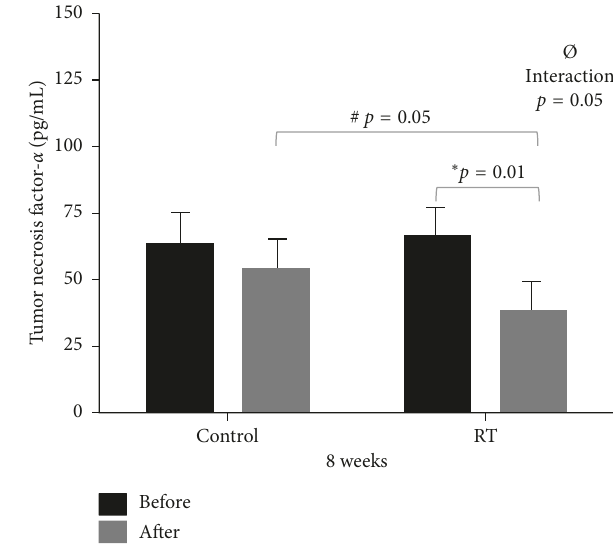
Figure 3: Dispersion measurements of tumor necrosis factor- α between Control ( n � 10) and RT ( n � 19) groups at Pre and Post moments. Two-way ANOVA test: ∗ statistically significant differ- ence ( p � 0 . 01) between Pre and Post moments in the RT group; # statistically significant difference ( p � 0 . 05) between Post mo- ments in the RT vs Control groups; Ø statistically significant in- teraction ( p � 0 .